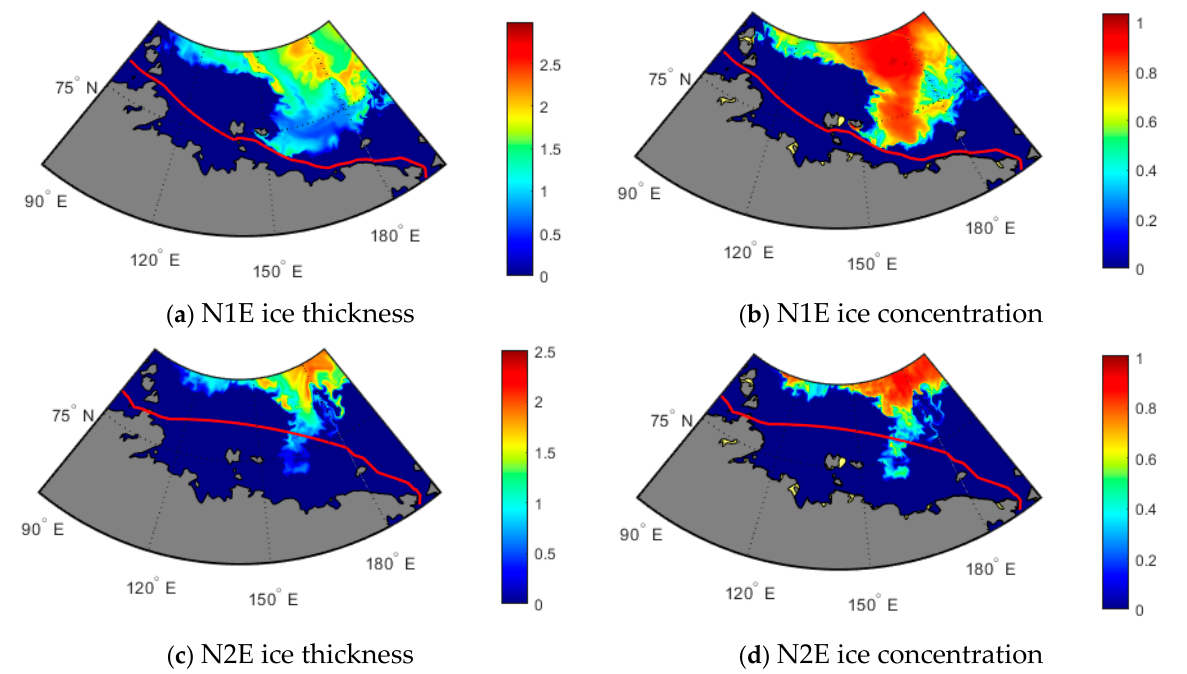
Figure 6. Overall ice conditions of the Arctic for both voyages.